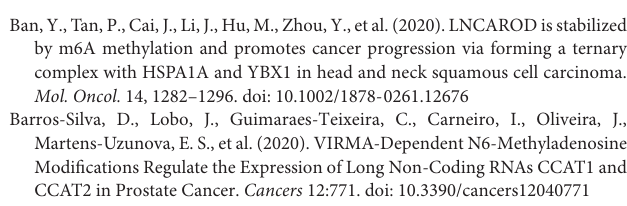
Supplementary Figure 1 | Survival analysis of m6A RNA methylation regulators in colon cancer patients. Supplementary Figure 2 | Risk scores were significantly associated with many clinical-pathological